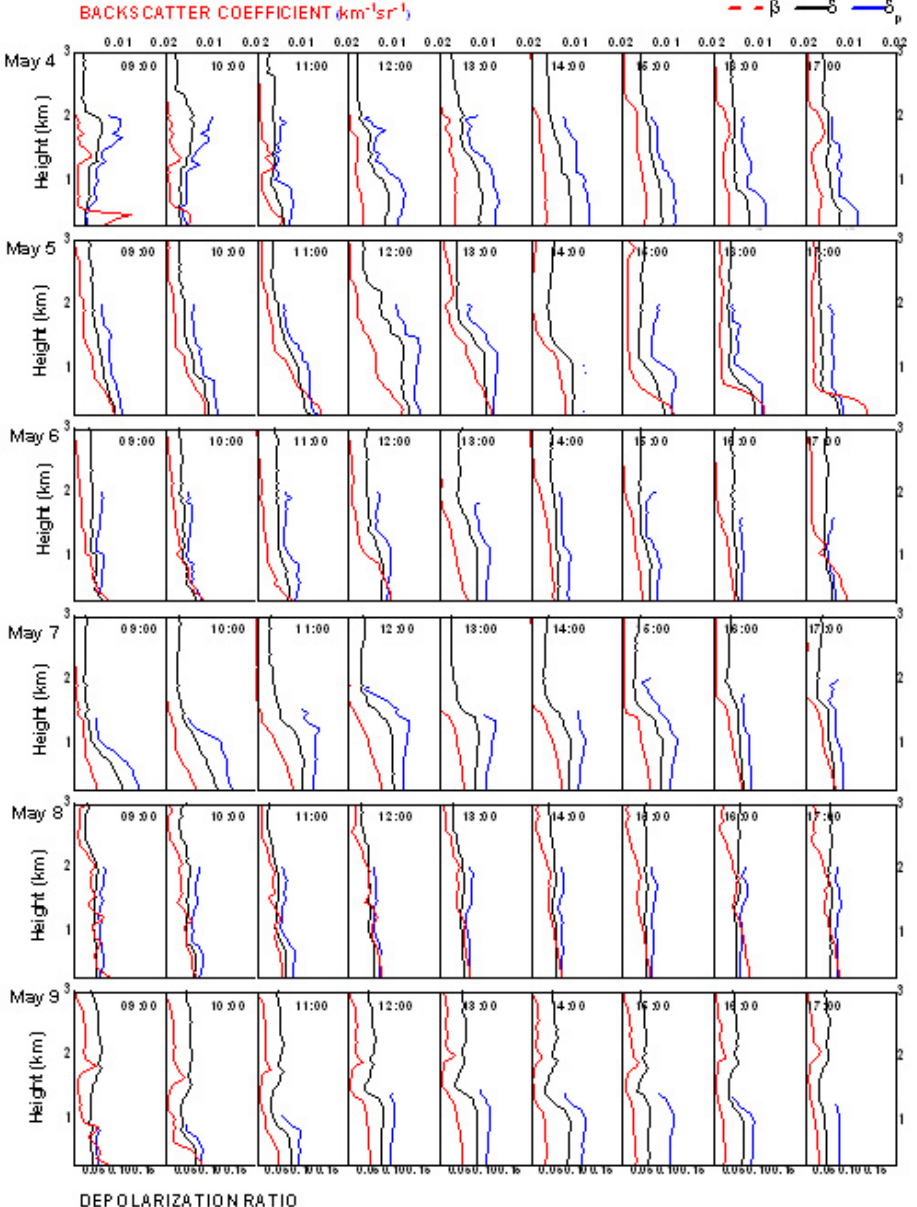
Fig. 3. Diurnal variation of hourly averaged aerosol backscattering coefficients, depolarization ratios, and linear particle depolarization ratios measured from 09:00 to